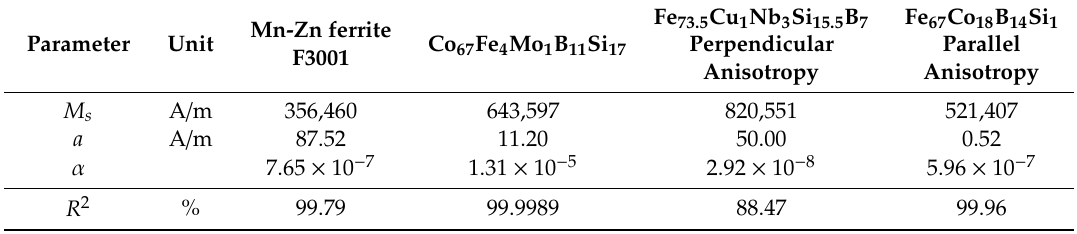
Table 1. Parameters of anhysteretic curve erf-based model identified during the optimization process. Parameter